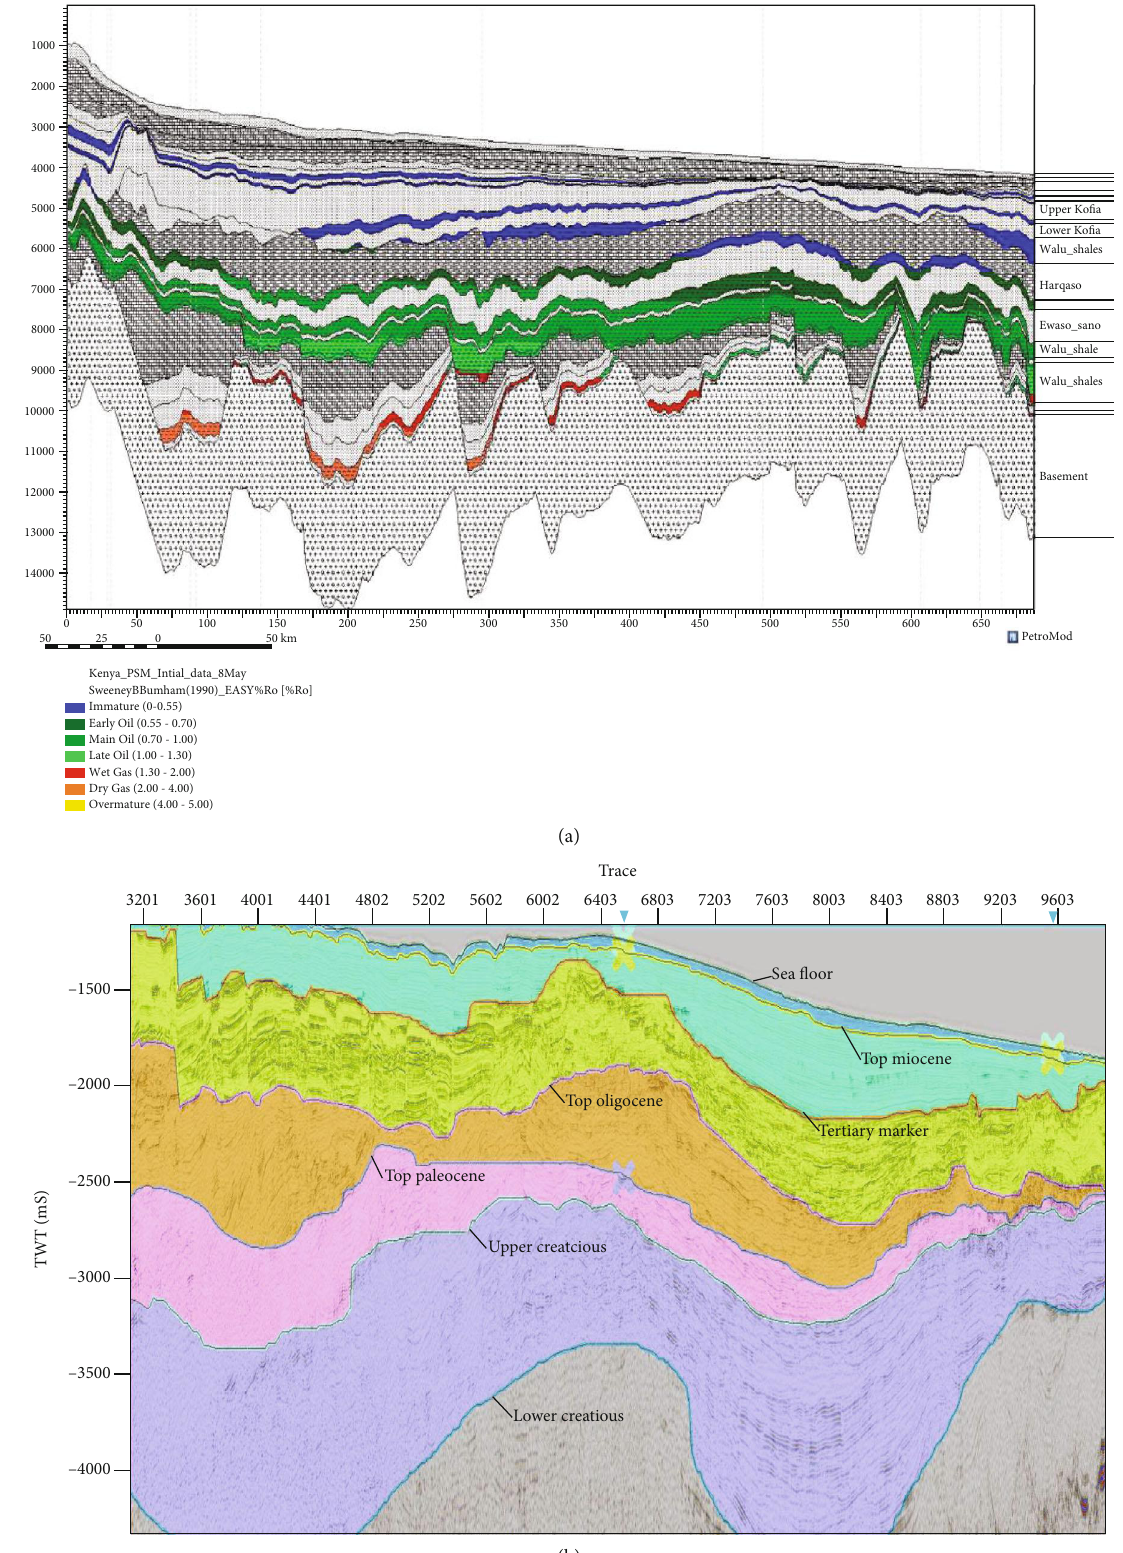
Figure 7: (a) Shows a 2D seismic section model. Based on the Sweeney and Burnham (1990) scale, the modelled present-day source rock maturity is highlighted by the regional line [2]. (b) Is a 2D seismic section showing Interpreted horizons along line 9 near Mbawa well indicating seven identi fi ed horizons as